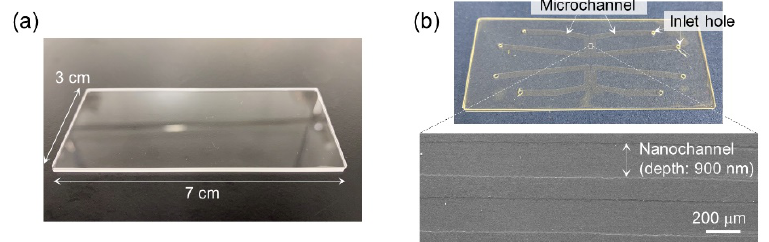
Figure 3. Low-temperature bonding of fused-silica glass substrates. ( a ) Photograph of bonded fused-silica glass substrates. ( b ) Photograph of a micro/nanofluidic device fabricated by bonding of a fused-silica glass substrates with microchannels and nanochannels.